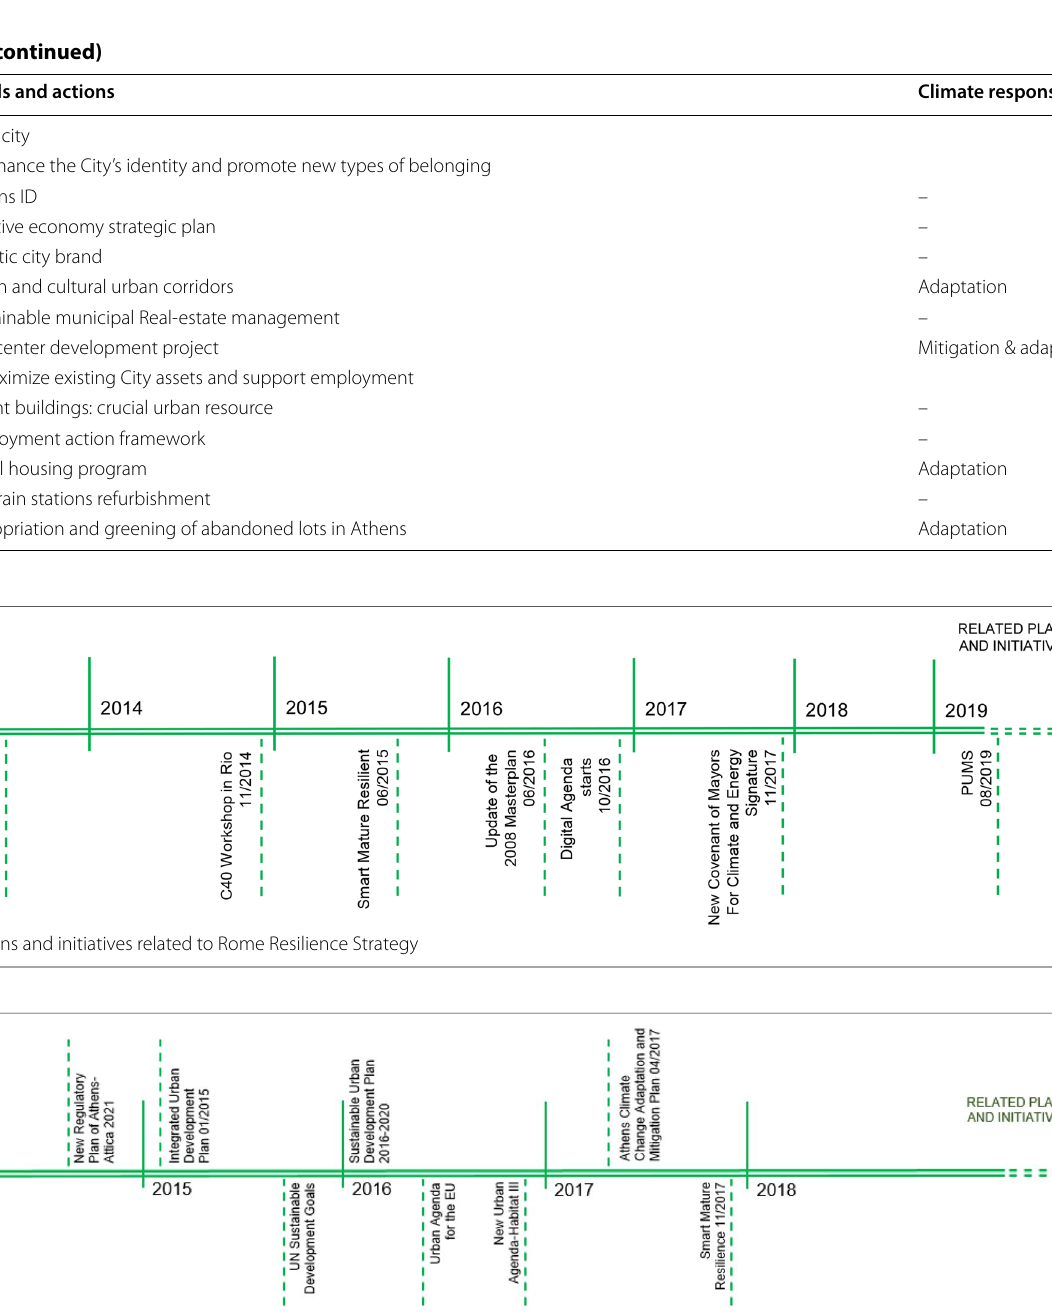
Fig. 10 Plans and initiatives related to Athens Resilience